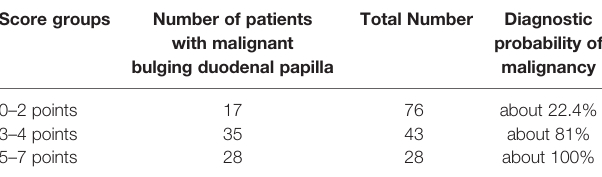
TABLE 4 | Patients with malignant bulging duodenal papilla in three score ranges. Score groups